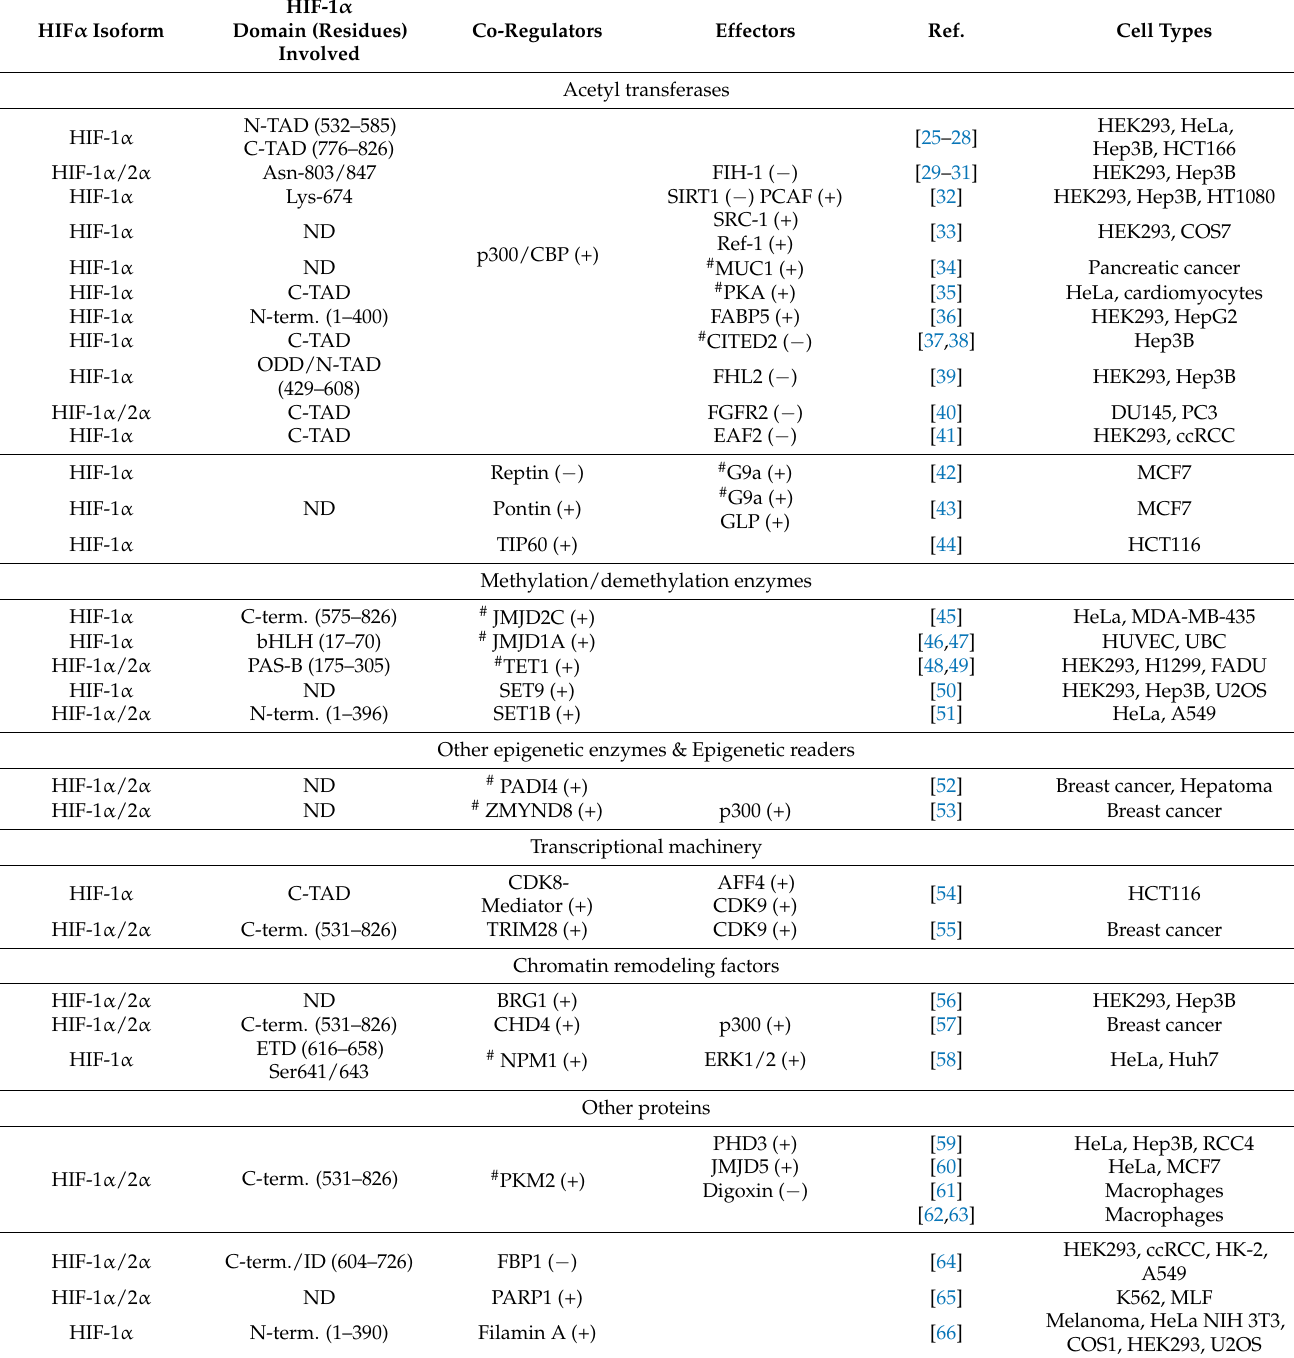
Table 1. A list of HIF-1 α -interacting HIF-1 co-regulators with their